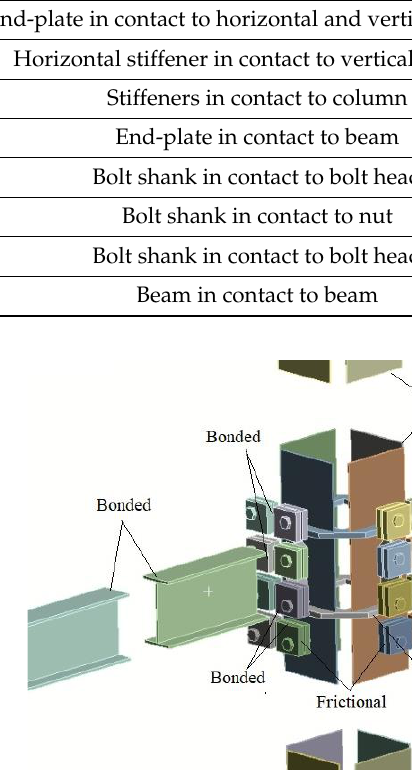
Figure 7. Meshing used in the numerical models.